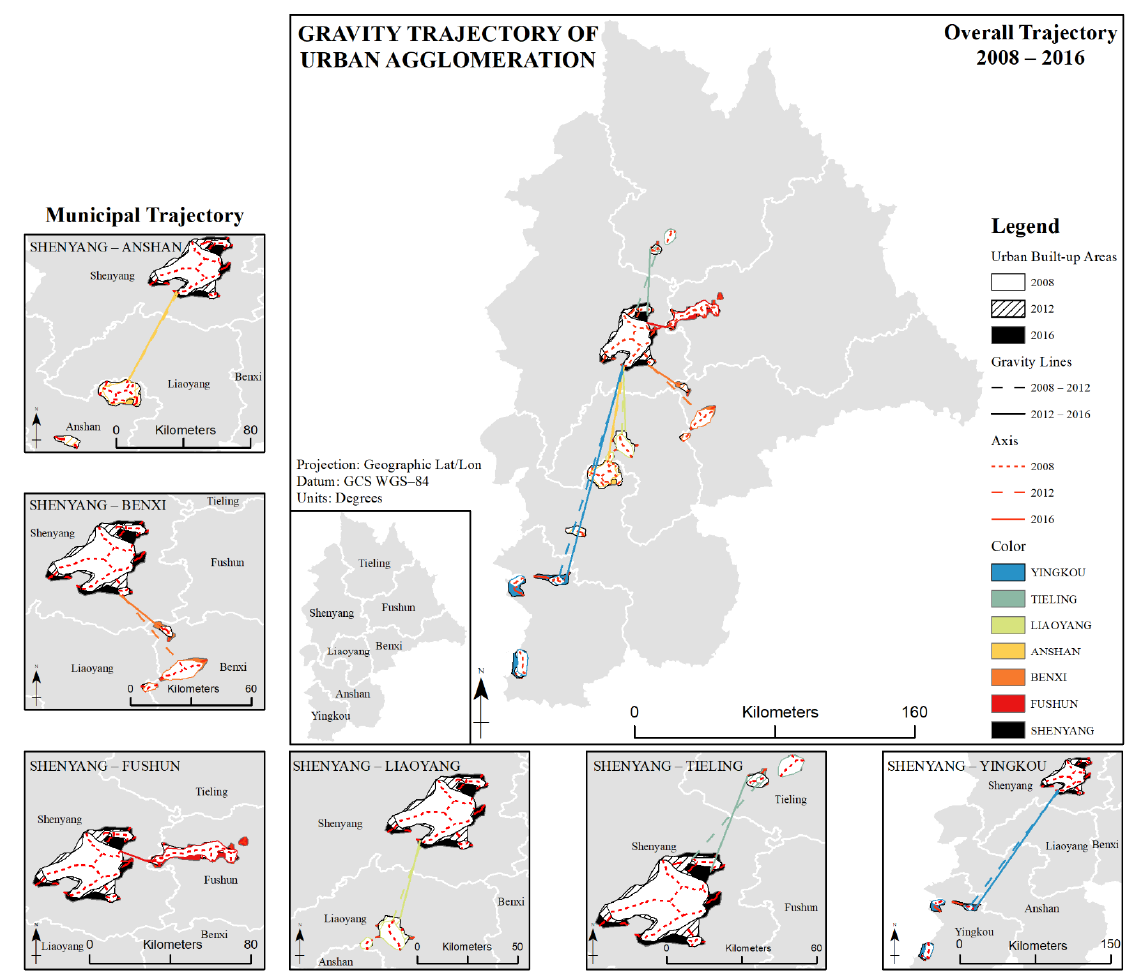
Figure 9. Gravity trajectory of central Liaoning urban agglomeration.